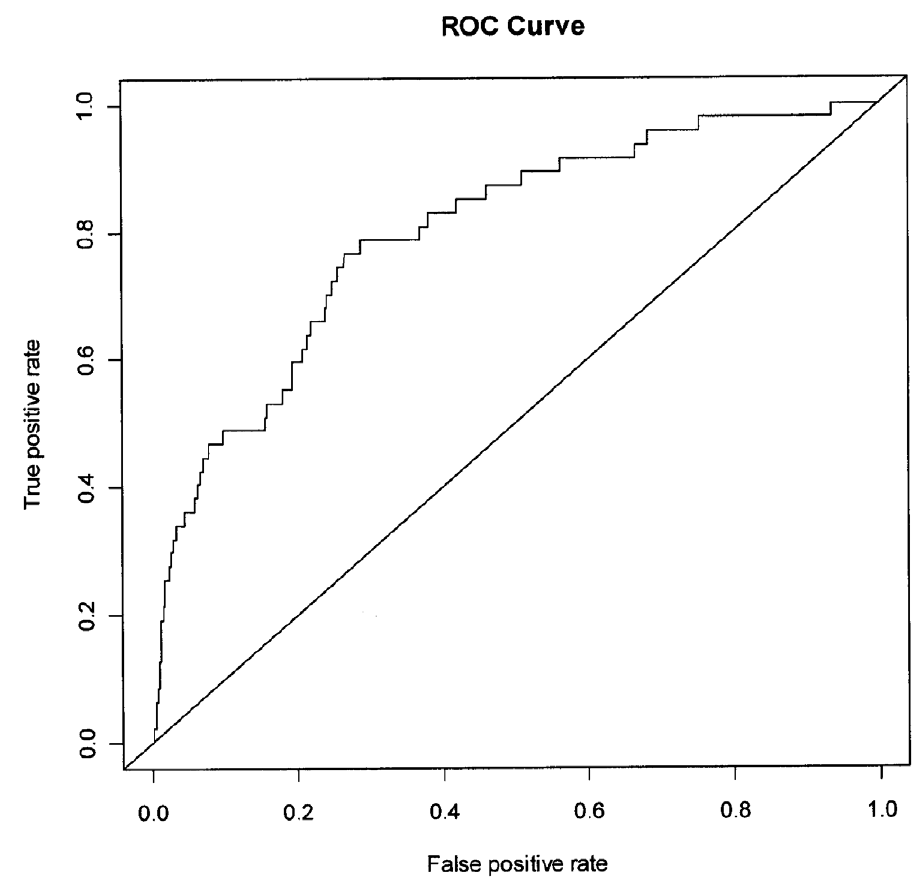
Figure 3. Receiver-operating characteristic curve for SPTB-PPROM.